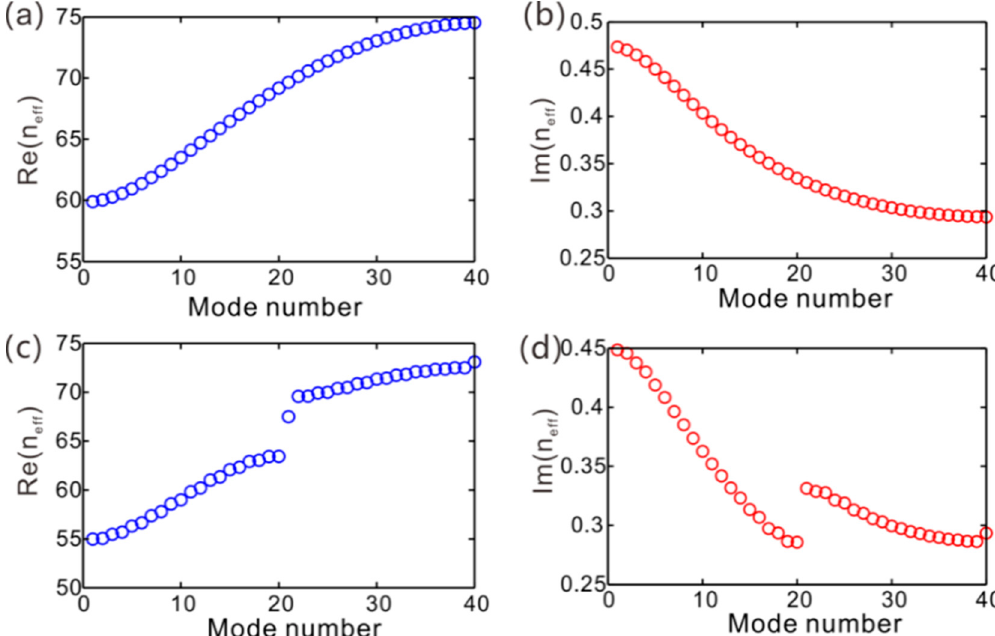
Figure 2. The e ff ective refractive index of supermodes for two di ff erent structures. ( a , b ) are the real Figure 2. The effective refractive index of supermodes for two different structures. (a) and (b) are the and imaginary parts of refractive index for µ 2 = 0.15 eV, respectively. ( c,d ) are Re (n e ff ) and Im (n e ff ) for real and imaginary parts of refractive index for μ 2 = 0.15 eV, respectively. (c) and (d) are Re ( n eff) and = 0.18 eV, respectively. In all cases, µ = 0.15 µ 2 1 Im ( n eff ) for μ 2 = 0.18 eV, respectively. In all cases, μ 1 = 0.15 eV.